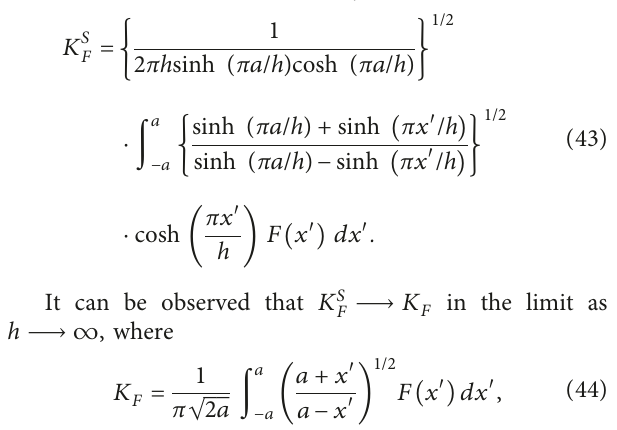
Figure 2: Variation of the scaled phonon stress component, r √ σ K S T , around a crack ψ z / (cid:31)